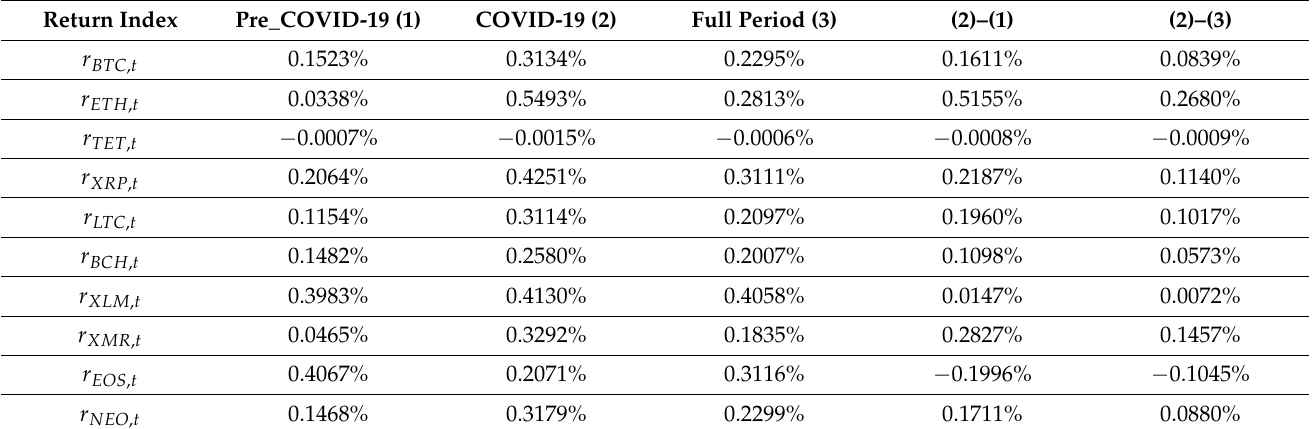
Table 5. Comparison of the average growth rates of the 10 cryptocurrencies’ return indices in percentages for the three periods.